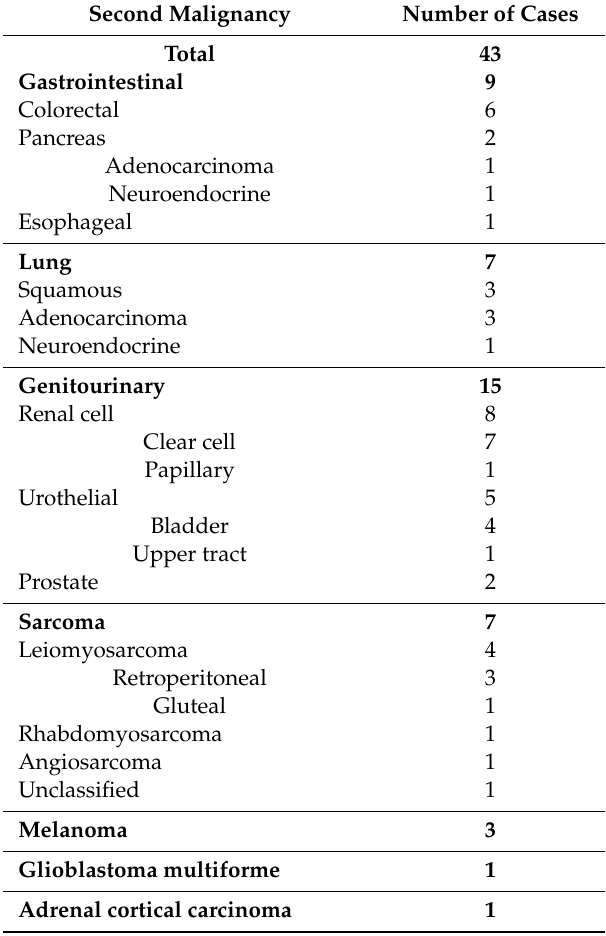
Table 1. Distribution of subsequent malignant neoplasms (SMNs) in testicular germ cell tumor (TGCT) cohort. Second Malignancy Number of